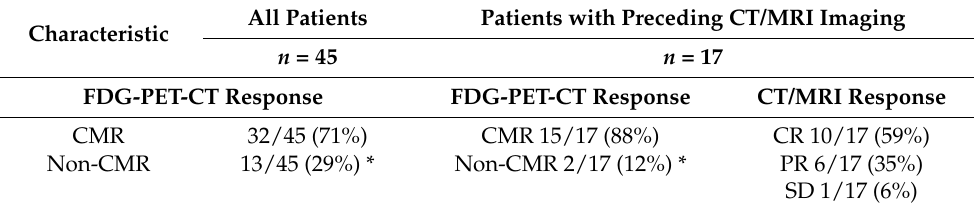
Table 2. Evaluation of FDG-PET-CT scan and of preceding CT/MRI at time of therapy discontinuation. All Patients Patients with Preceding CT/MRI Characteristic